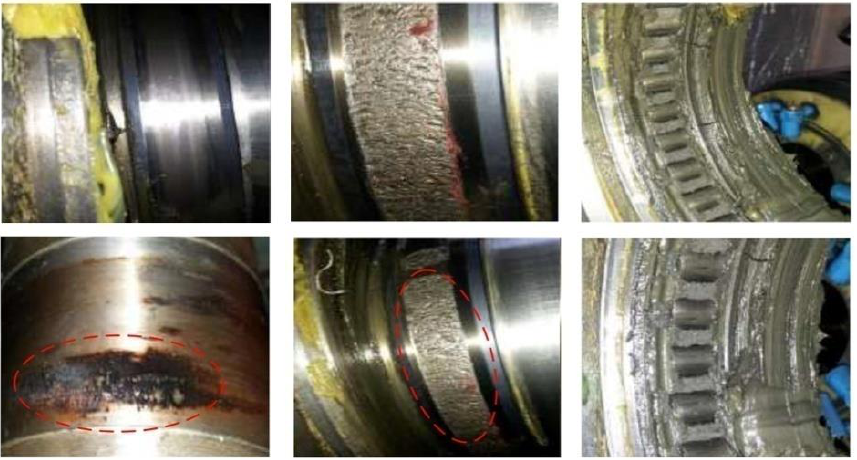
Figure 8. Common defects of inner race generator rolling bearings of wind turbines. Reproduced from [85], Elsevier.